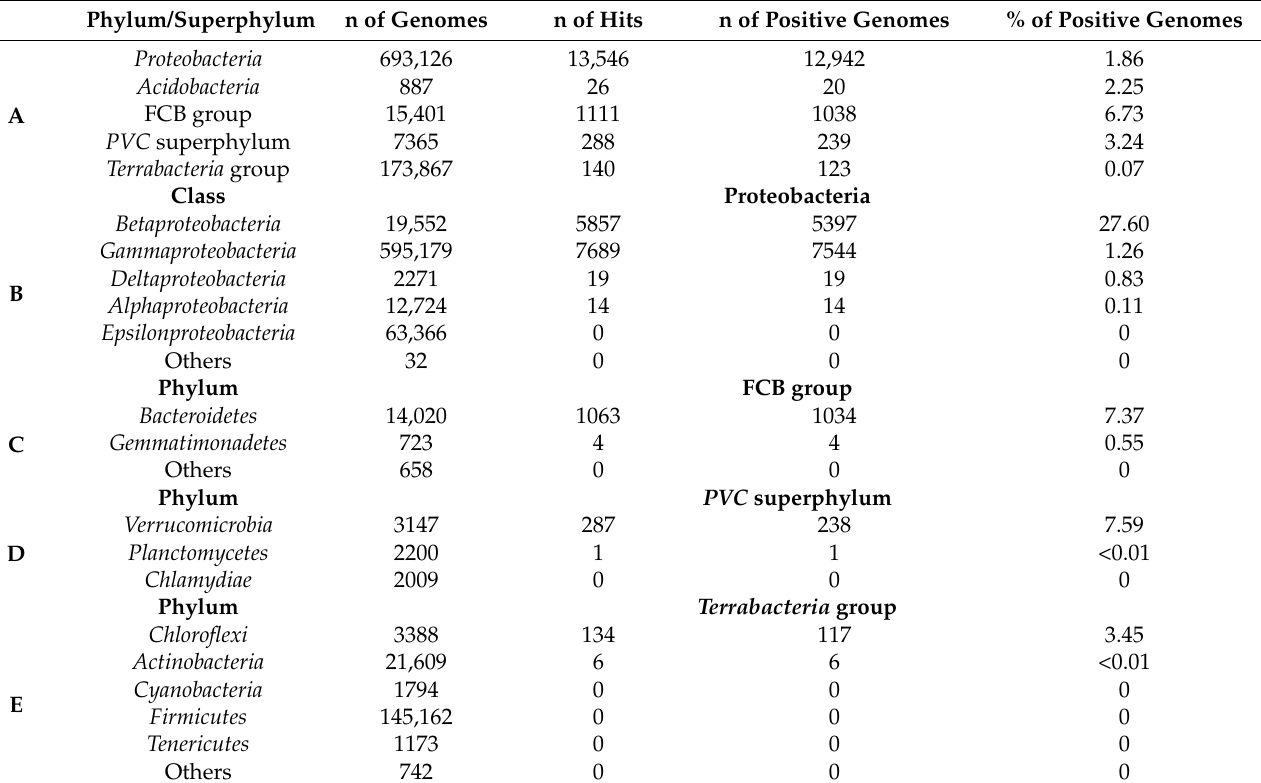
Table 1. Screening results for the presence of azurin in the available bacterial genomes. (A) Phyla/ Superphyla positive for azurin presence. List of phyla or Superphyla found positive for the presence of azurin. For each phylum the number of analyzed genomes is reported together with the number (n) of positive hits for azurin. (B–D) Number of hits found in the various phyla. Number of hits for phylum Proteobacteria (B), FCB group (C), PVC superphylum (D) and Terrabacteria group (E). Numbers of genomes for each class/phylum is reported as well as number of